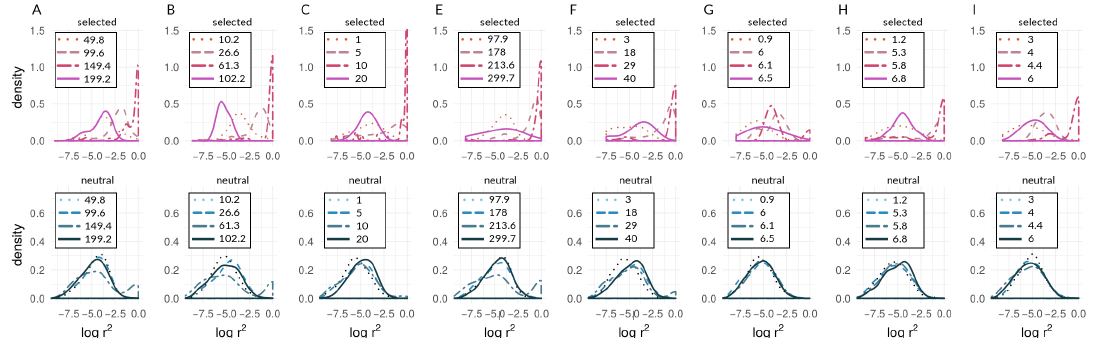
Figure 6. Density curves of within-deme LD as log ( r 2 ) for representative generations of bu2s runs (corresponding to Runs A,B,C,E,F,G,H, and I in Figures 4 and 5), where ( A ) s = 0.005, m = 0.01, ( B ) s = 0.01, m = 0.01, ( C ) s = 0.02, m = 0.01, ( E ) s = 0.01, m = 0.1, ( F ) s = 0.02, m = 0.1, ( G ) s = 0.02, m = 0.00002, ( H ) s = 0.02, m = 0.0001, and ( I ) s = 0.02, m = 0.0002. Numbers in legends ( × 10 3 ) show the number of generations elapsed for respective lines and colors. Times vary from panel to panel because of the differing numbers of generations required for divergence with different parameters. In each case, the times chosen represent early, early-middle, late-middle, and late stages of